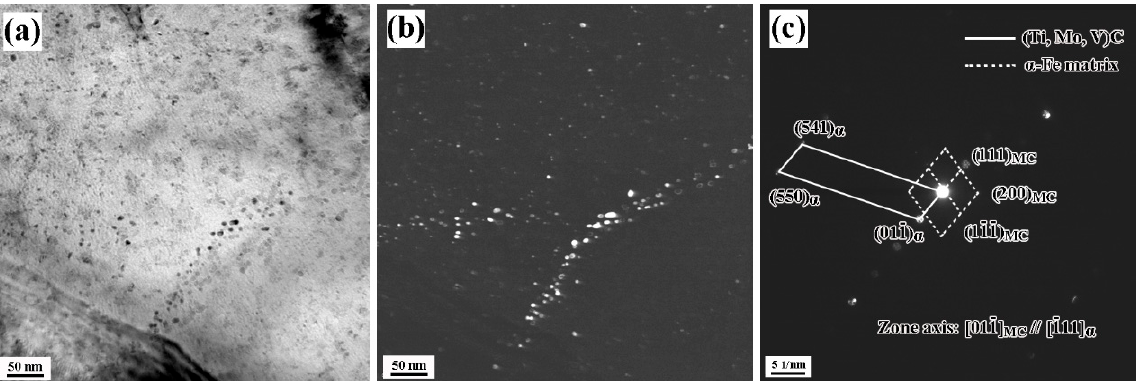
Figure 3. The ( a ) bright-field image ( b ), dark-field image of precipitates and ( c ) diffraction pattern of precipitates.